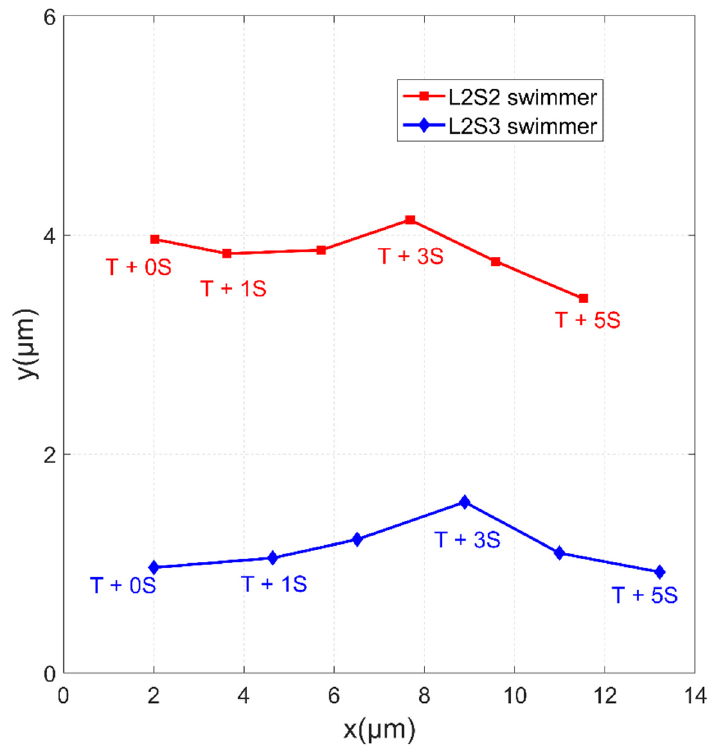
Figure 12. Trajectories for the swimmers shown in Figure 11 in a period of 5 s.